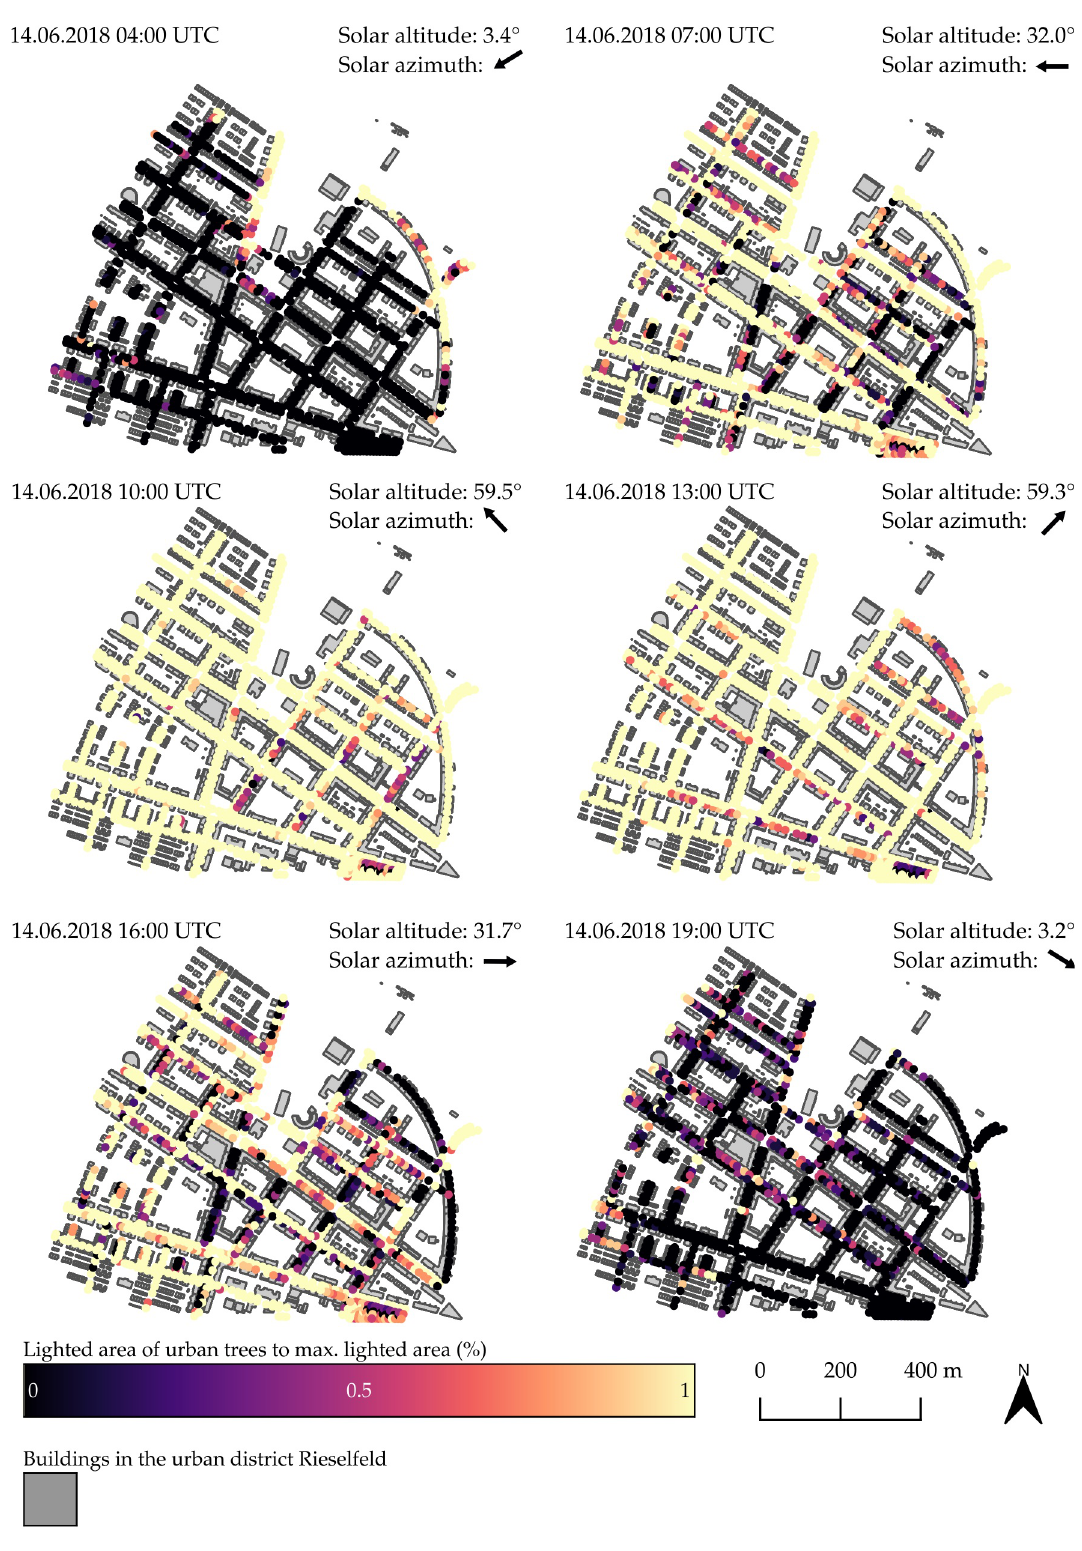
Figure 10. Ratio between sunlit area and max. sunlit area of urban trees for the 14th of June under clear-sky conditions. It is observable that the effect of the solar altitude angle is decreased compared to March because the solar altitude angle is of greater magnitude. It is also conspicuous, that the lighting of the trees starts earlier and lasts longer, compared to